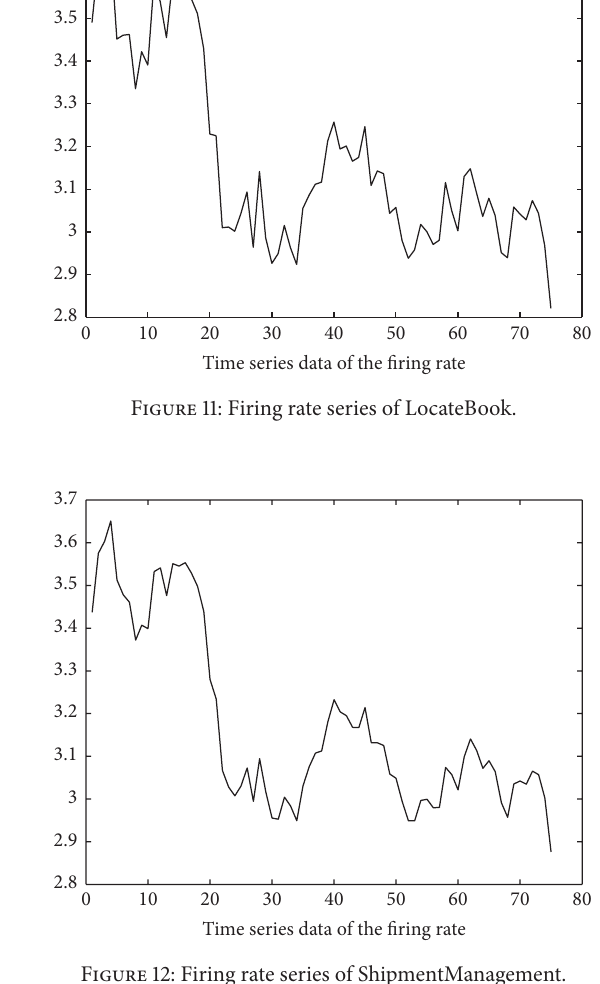
Figure 12: Firing rate series of ShipmentManagement.